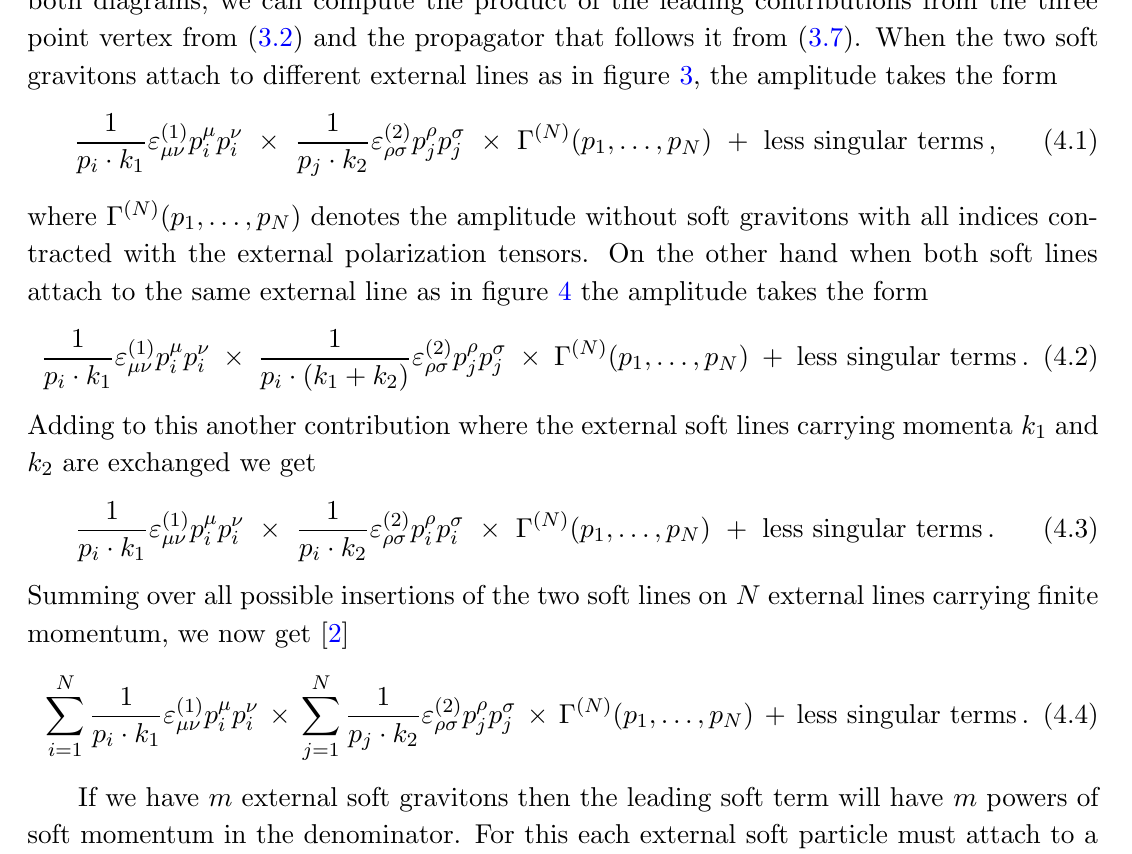
in (cid:12)gure 3 or both soft gravitons attaching on the same external leg as in (cid:12)gure 4. In both diagrams, we can compute the product of the leading contributions from the three point vertex from (3.2) and the propagator that follows it from (3.7). When the two soft gravitons attach to di(cid:11)erent external lines as in (cid:12)gure 3, the amplitude takes the